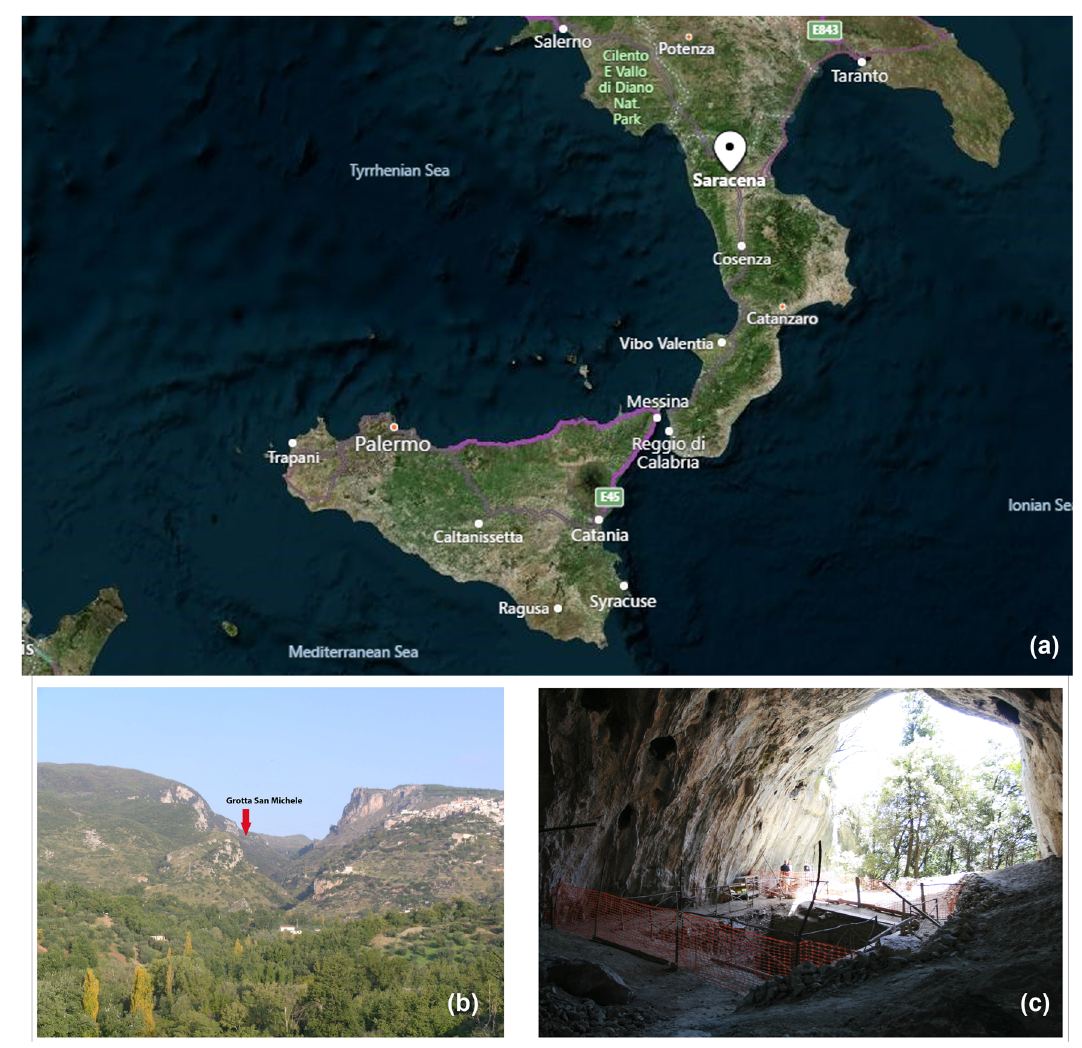
Figure 1: Location of Grotta San Michele Arcangelo di Saracena ( Cosenza ) ( a ) ; panoramic view of the Garga valley where the cave opens ( b ) ; the inner part of the cave during an excavation campaign ( c )